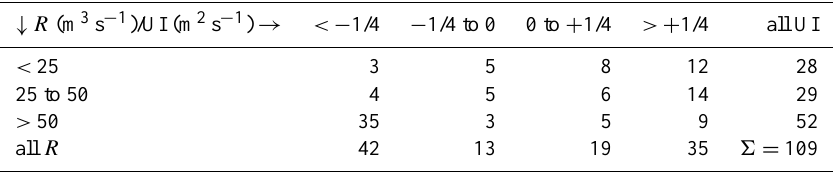
Table 2. Number of invalid events (cloud bias) of the time series (1 January 2005 to 31 March 2014) grouped according to different intervals of upwelling index (UI) and river discharge ( R ).